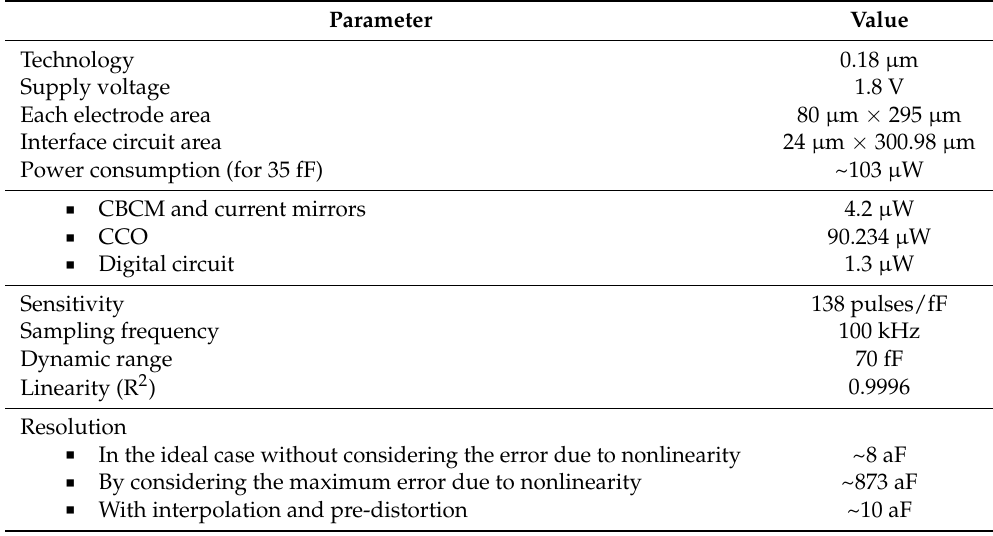
Figure 23. Sensing capacitance versus fibroblast cell confluency percentage. Table 3. Core-CBCM capacitance-to-frequency converter specifications.